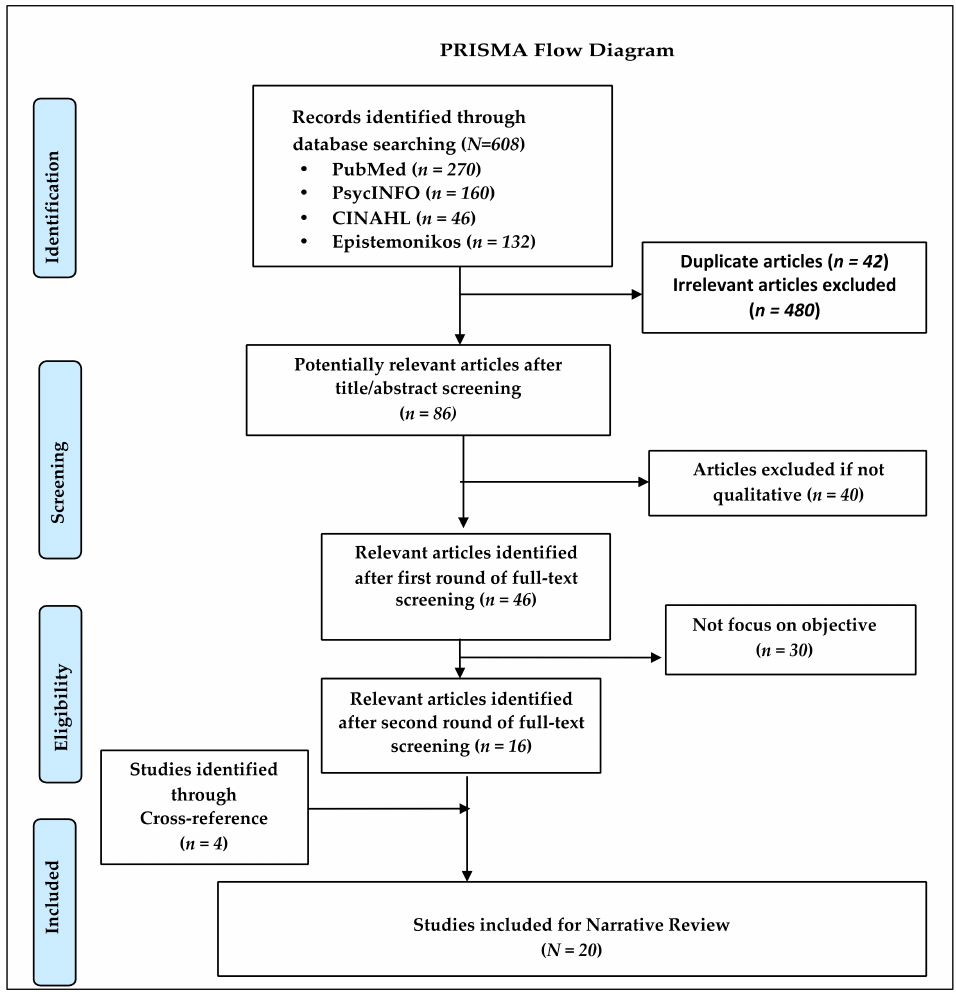
Figure 1. PRISMA flow